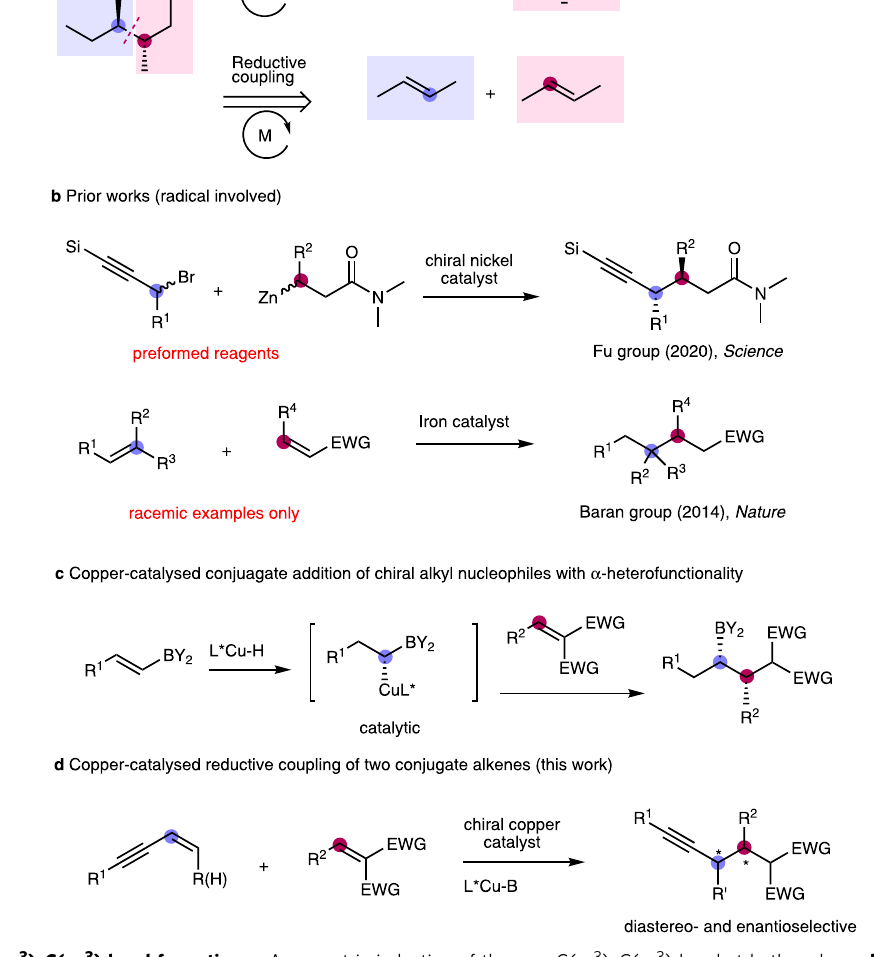
Fig. 1 Overview of C(sp 3 ) – C(sp 3 ) bond formation. a Asymmetric induction of the new C( sp 3 ) – C( sp 3 ) bond at both carbons. b Prior works (radical involved). c Copper-catalysed conjugate addition of chiral alkyl nucleophiles with α -heterofunctionality. d Copper-catalysed reductive coupling of two conjugate alkenes (this